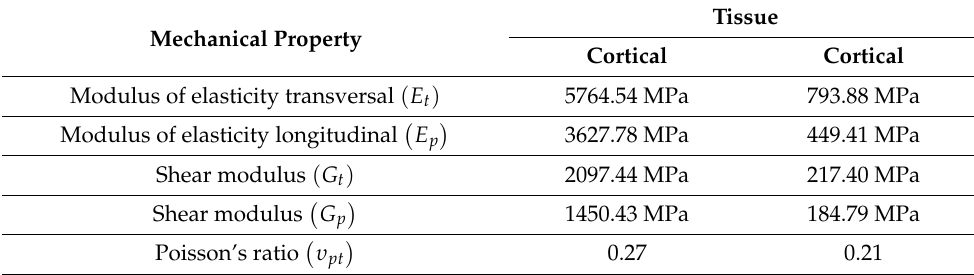
Table 1. Bone tissue with OI properties for the cortical and trabecular.